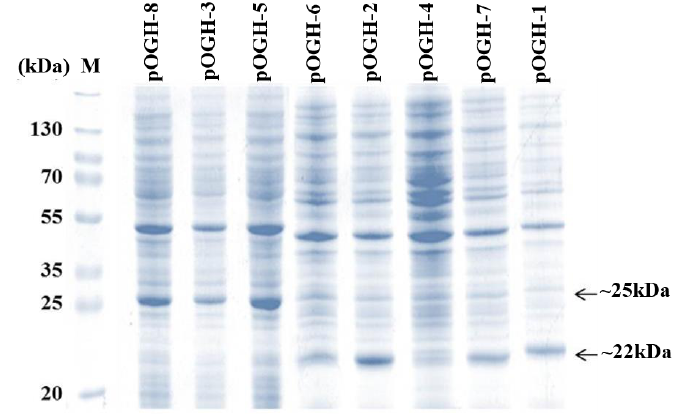
Figure 1. Total cell protein analysis of Escherichia coli transformed with pOGH-1 to -8 constructs on 15% SDS gels. M represents a molecular weight marker. pOGH-1 to -8 show expression of recombinant ovine growth hormone (rOGH) in eight constructs.